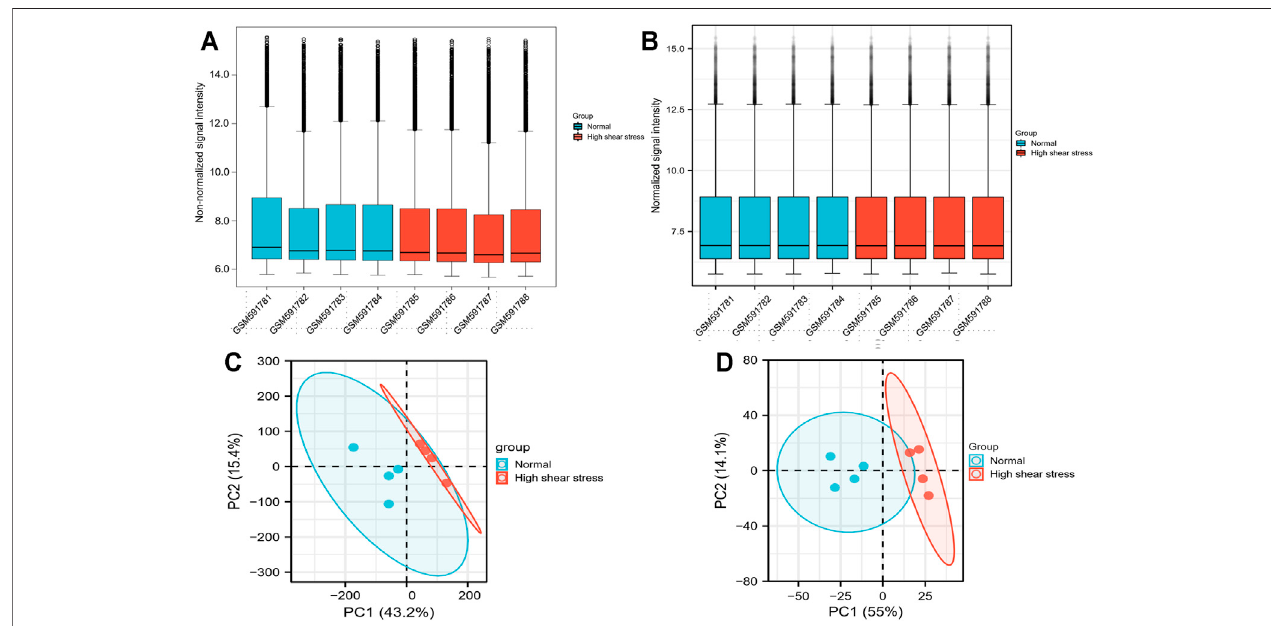
FIGURE 2 | Data processing. (A) Boxplot for GSE23289 before quantile normalization. (B) Boxplot for GSE23289 after quantile normalization. (C) The PCA for GSE23289 before quantile normalization. (D) The PCA for GSE23289 after quantile